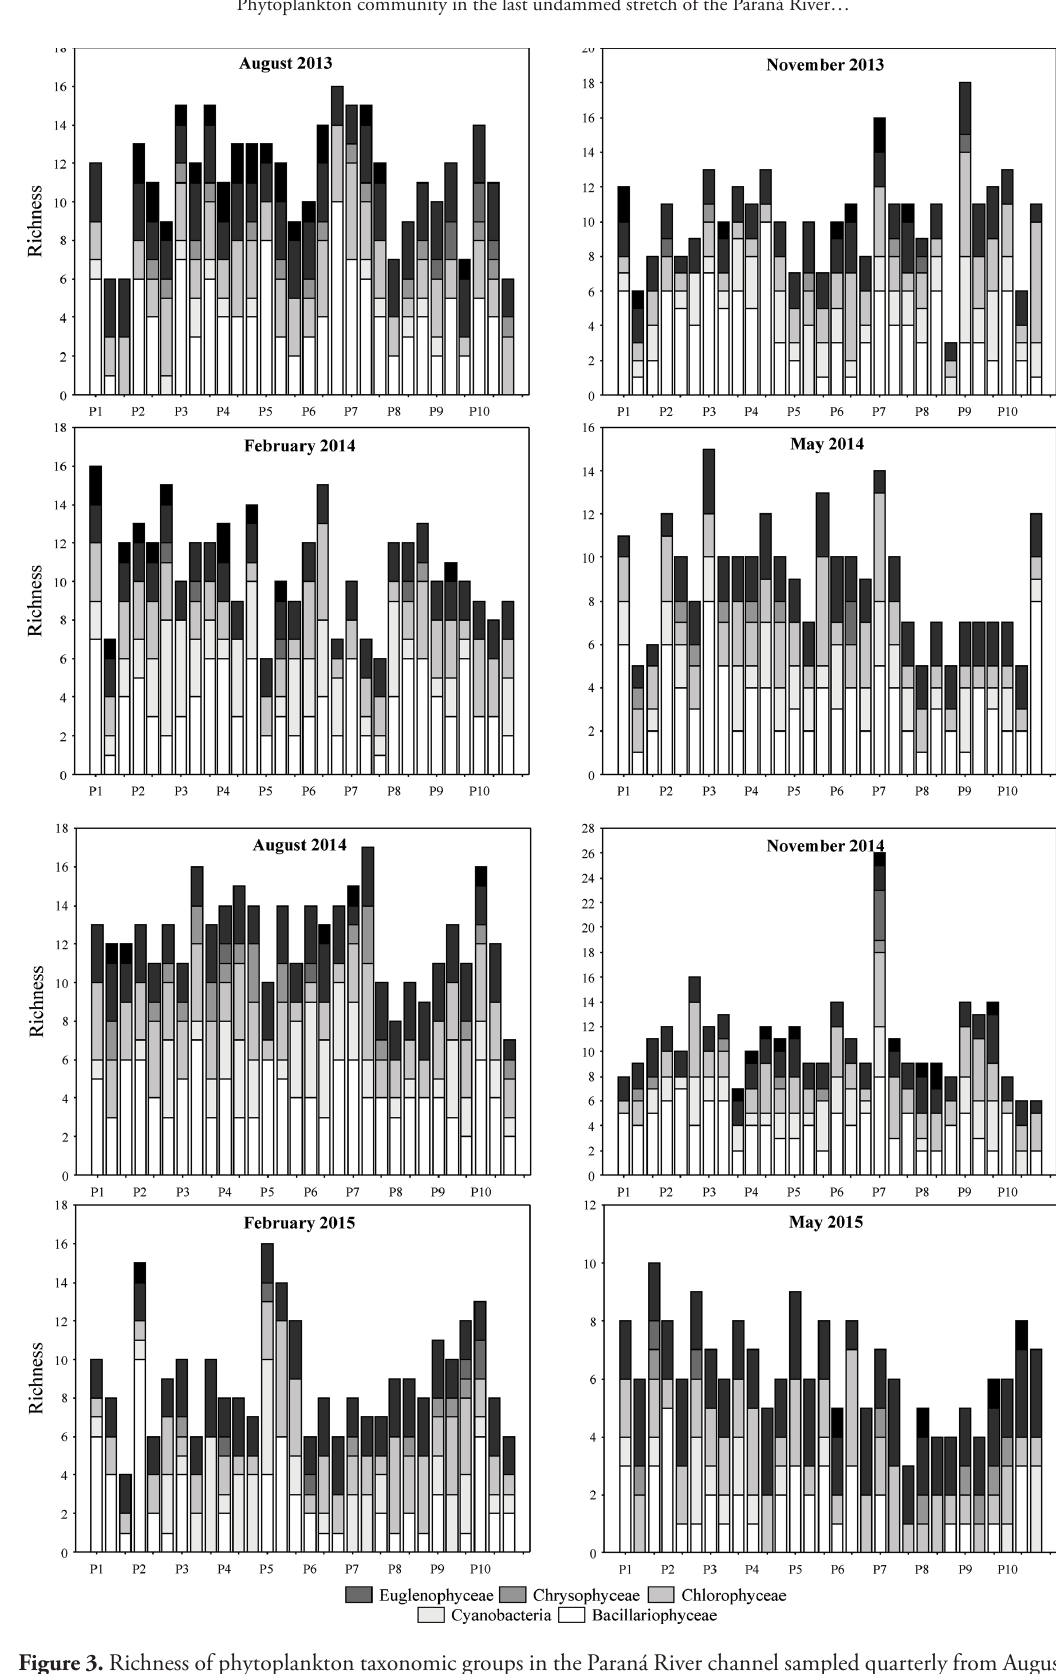
Figure 3. Richness of phytoplankton taxonomic groups in the Paraná River channel sampled quarterly from August 2013 to May 2015. P1 to P10 – transects sampled in the right and left margins and in the center of the Paraná River main